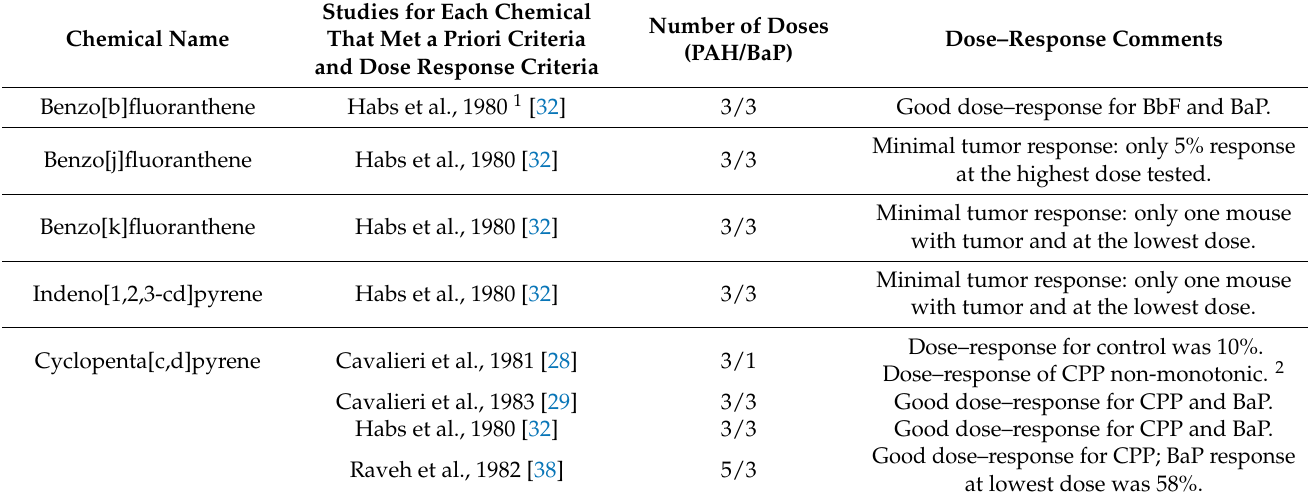
Table 6. Target PAHs/Studies that met Dose–Response